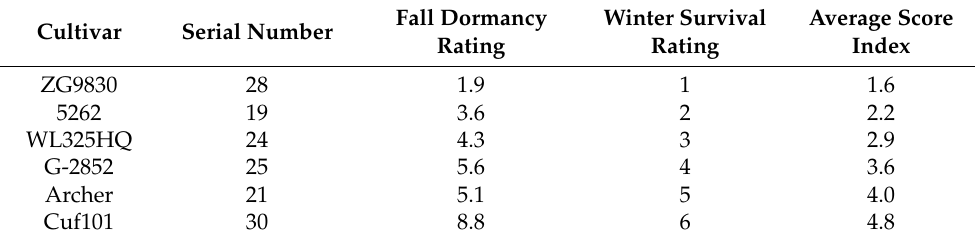
Table 2. Standard U.S. alfalfa cultivars used in the